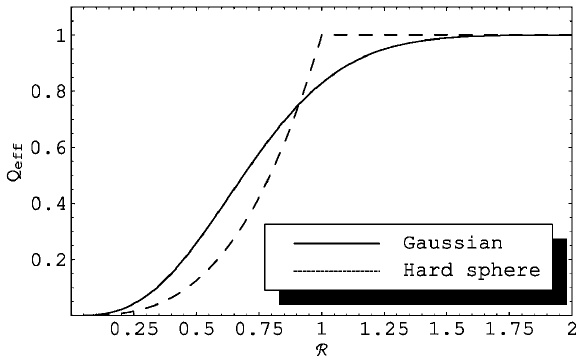
FIG. 2. Fractional effective charge as a function of R [as defined in (21)] for a macroparticle with Gaussian (solid line) and ‘‘hard spheroid’’ (dashed line) form factors possessing the same covariance matrix. Note that for a hard sphere of radius